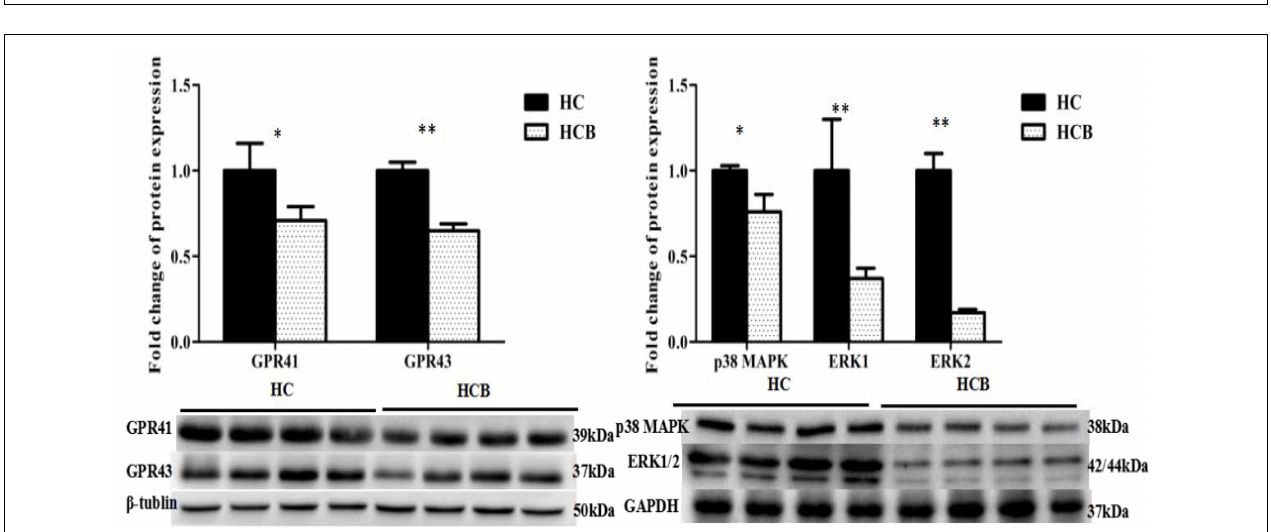
FIGURE 4 | Effect of sodium butyrate on the protein expressions of GPR41/43 and MAPKs protein in the cecal mucosal tissue of lactating goats. Fold changes in protein expression are indicated on the ordinate axis (mean ± SEM), and significant differences ( ∗ P < 0.050, ∗∗ P < 0.010) are indicated. The bands (1–4) from left to right for each candidate protein represent the levels of the corresponding proteins in the cecal mucosal tissue of lactating goats in the HC group. The bands (5–8) from left to right for each candidate protein represent the levels of the corresponding proteins in the cecal mucosal tissue of lactating goats in the HCB